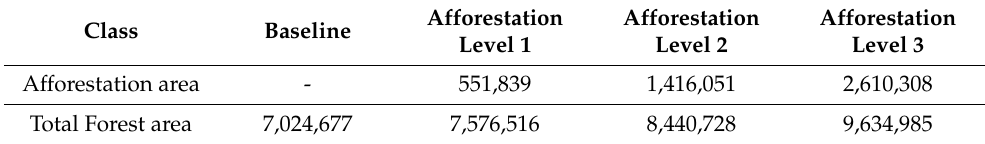
Table 1. Classification of the afforestation scenario with its amount by implementation level. Class